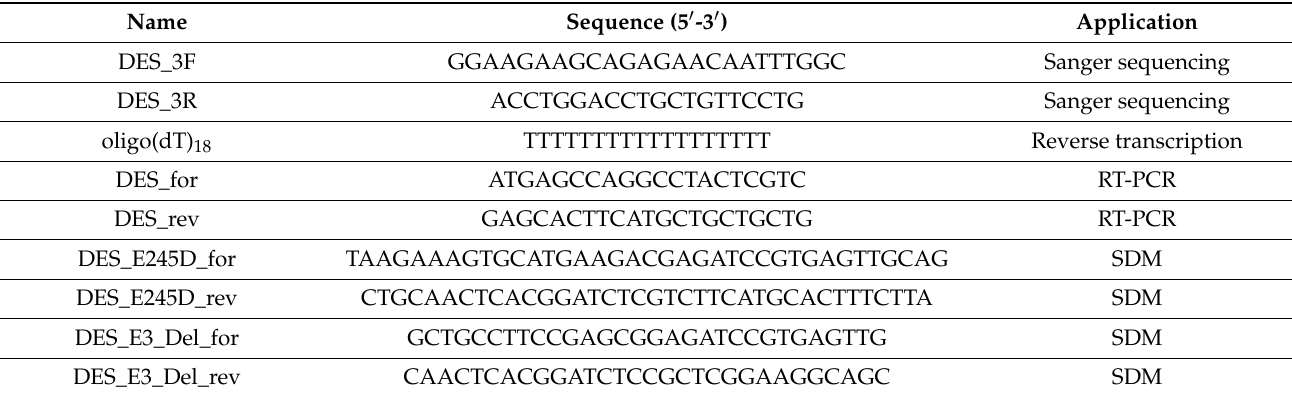
Table 1. Overview of the used oligonucleotides 1